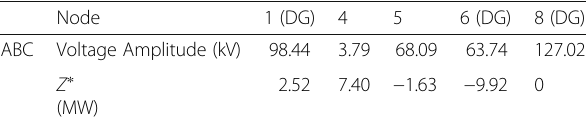
Table 3 Voltage amplitude and objection function values of key nodes (Fault 2)